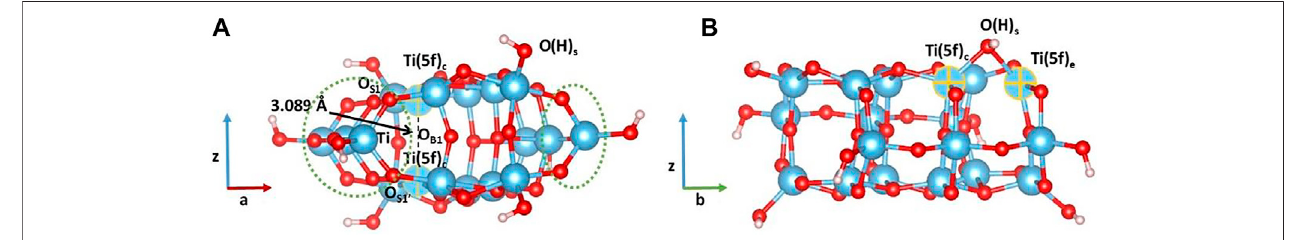
FIGURE 5 | Minimum-energy structures obtained at the B3LYP level of theory for defective cluster models containing one oxygen vacancy at (A) subsurface and (B) surface. Color code: O, red; H, white; Ti, blue.